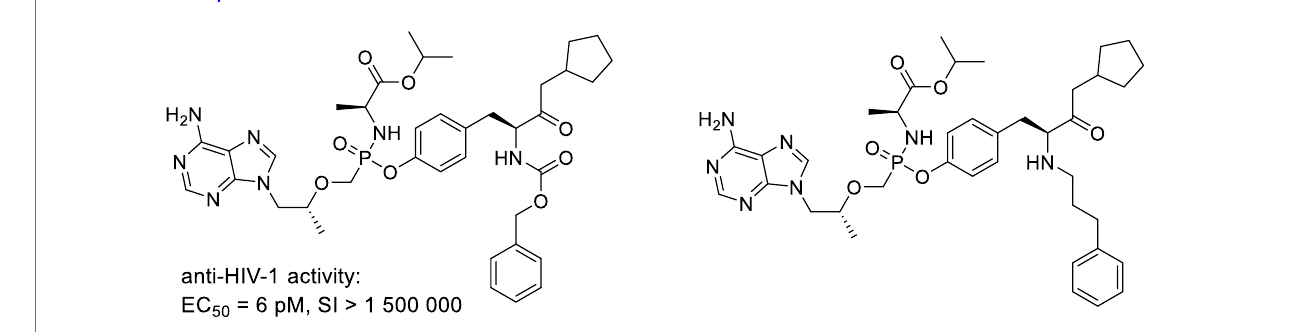
FIGURE 13 | Examples of peptidomimetic and tyrosine based prodrugs of acyclic nucleoside phosphonates.